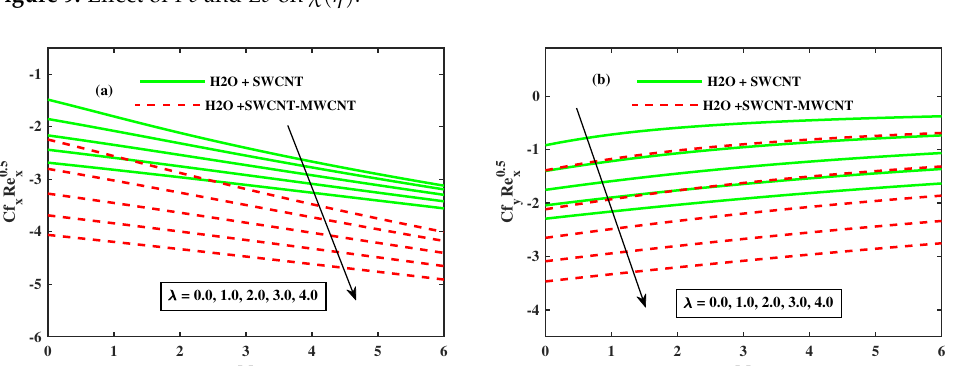
Figure 9. Effect of Pe and Lb on χ ( η ) .